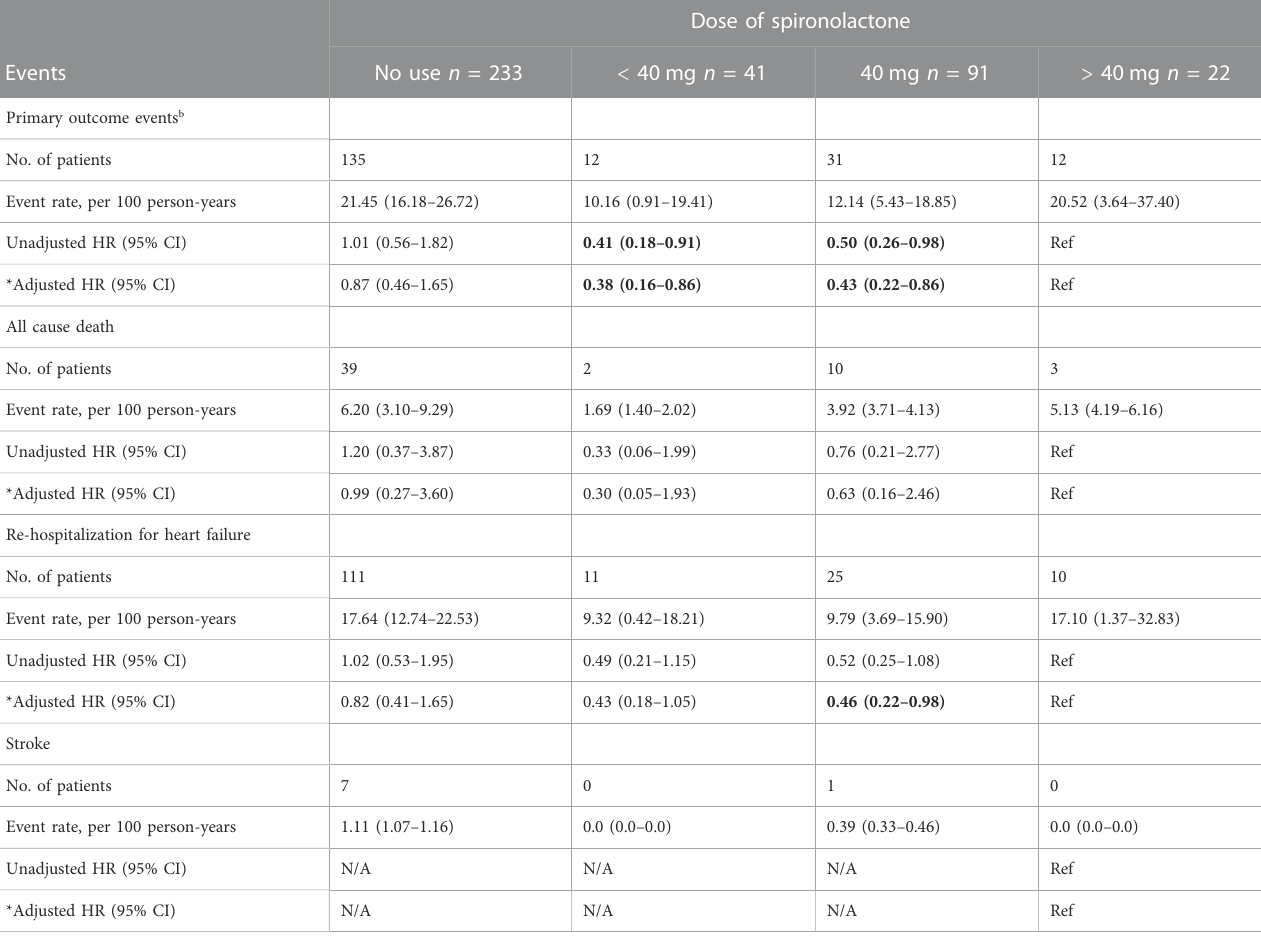
TABLE 5 Primary outcomes events in patients categorized according to the dose of spironolactone (Risk estimates calculated using > 40 mg as reference) a . Dose of spironolactone